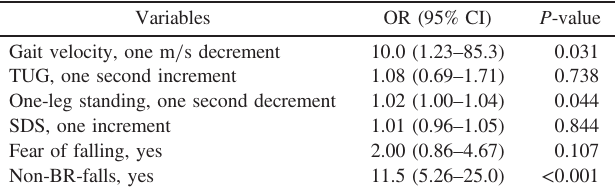
CI, con fi dence interval; Non-BR-falls, fall history in previous year without bicycling; OR, odds ratio; SDS, Zung Self-Rating Depression Scale; TUG, timed up & go. Model was adjusted for age, sex, BMI, comorbidities, number of medication, and frequency of riding a bicycle.